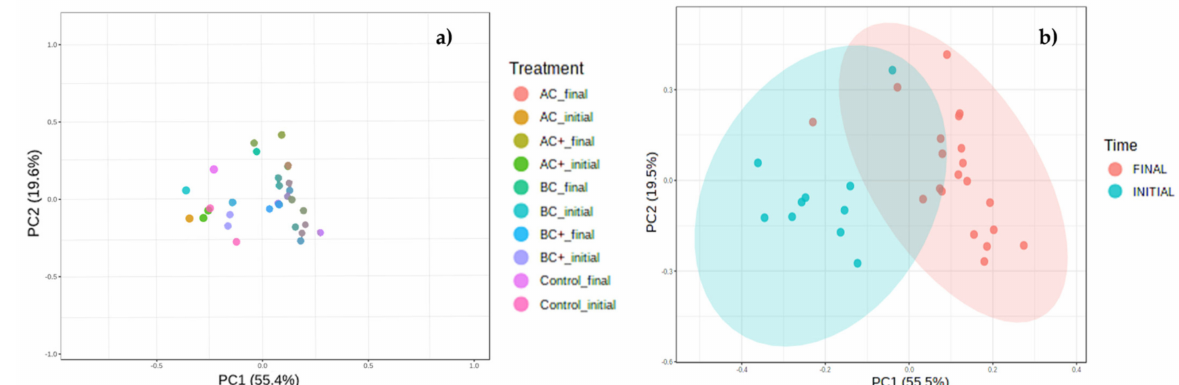
Figure 6. Principal component analysis of effect of treatment ( a ) and time ( b ) on molecular functions represented in terms of functional orthologs (KEGG KO) in control soil and amended soils at low (AC and BC soils) and high doses (AC+ and BC+ soils). Ellipses were drawn only when 95% of the data fell inside the